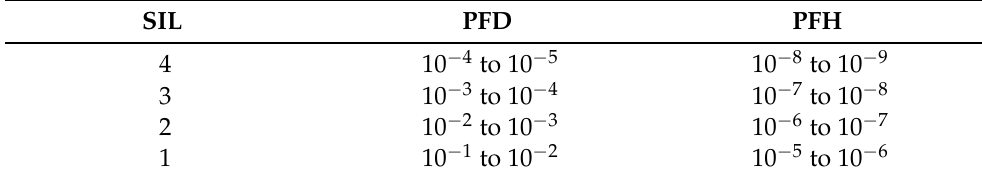
Table 1. Resulting safety integrity level (SIL) from different failure probabilities (PFD and